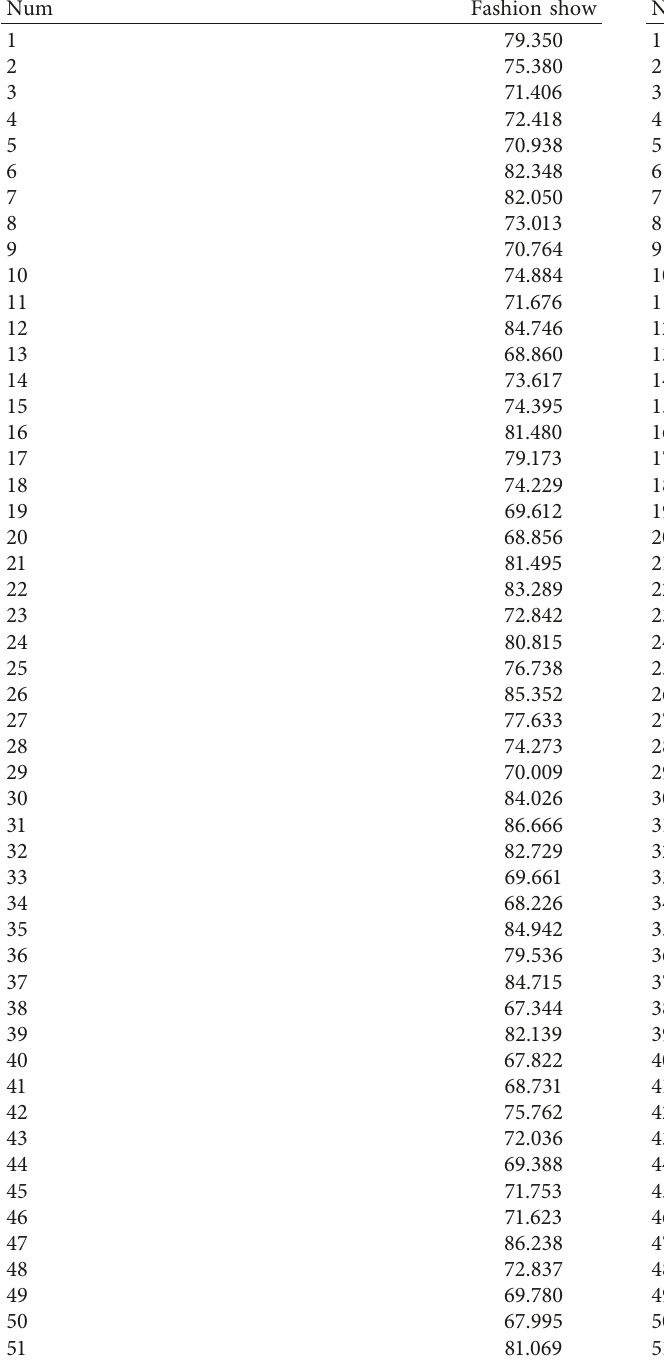
Table 1: Verification of clothing display effect. Table 2: Functional verification of online